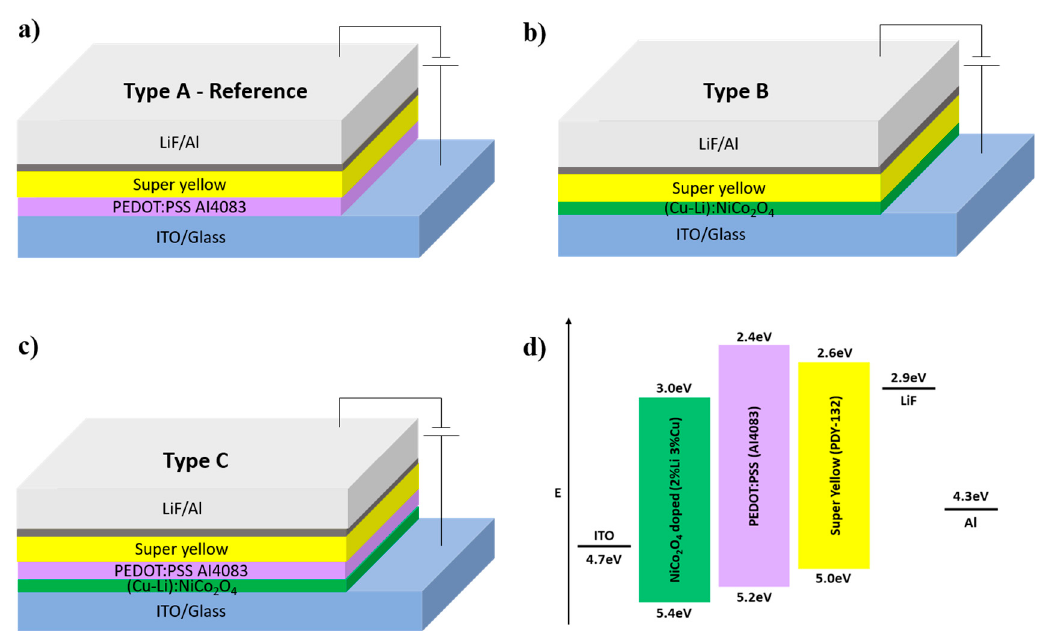
Figure 3. Schematic structures of the solution-processed OLED devices ( a – c ), ( d ) schematic of flat band diagram of the standard configuration super-yellow OLED device. Energy levels of each material were acquired from the following references, (Cu-Li):NiCo 2 O 4 [28] PEDOT:PSS [40] and Super Yellow [41].